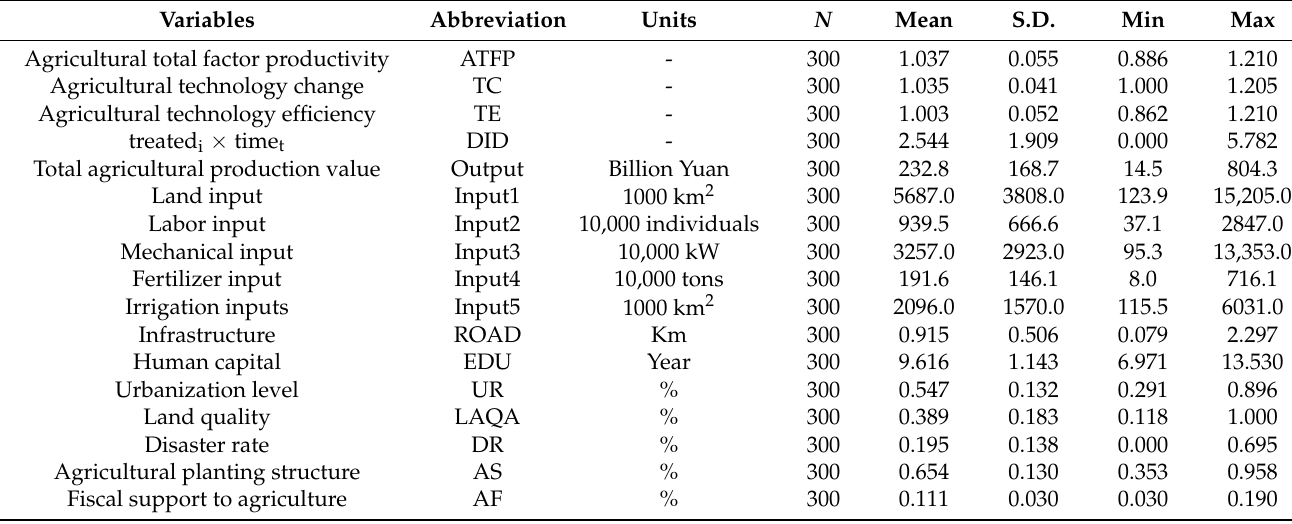
Table 1. Descriptive statistics of variables.